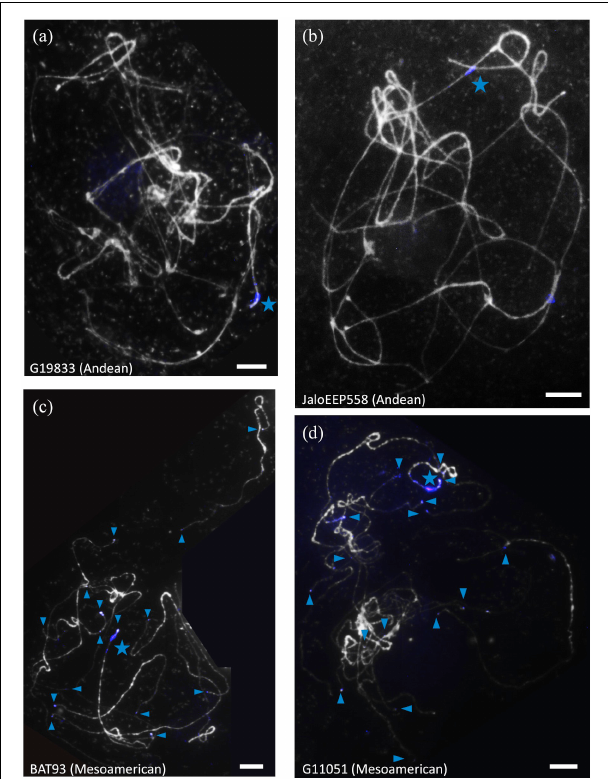
FIGURE 3 | Localization of FISH-CNL3/4 probe on pachytene chromosomes of common bean genotypes from the Andean and Mesoamerican gene pools. Chromosomes are counterstained with DAPI (gray), and FISH-CNL3/4 signals are in blue. The Co-2 locus is indicated by a blue star, and FISH-CNL3/4-labeled terminal knobs are indicated by blue arrowheads. (a) G19833 (Andean), (b) JaloEEP558 (Andean), (c) BAT93 (Mesoamerican), (d) G11051 (Mesoamerican). These experiments were done at least twice for each genotype with similar results. The number of loci for each probe was confirmed in at least three cells per experiment. Bars = 10 µ